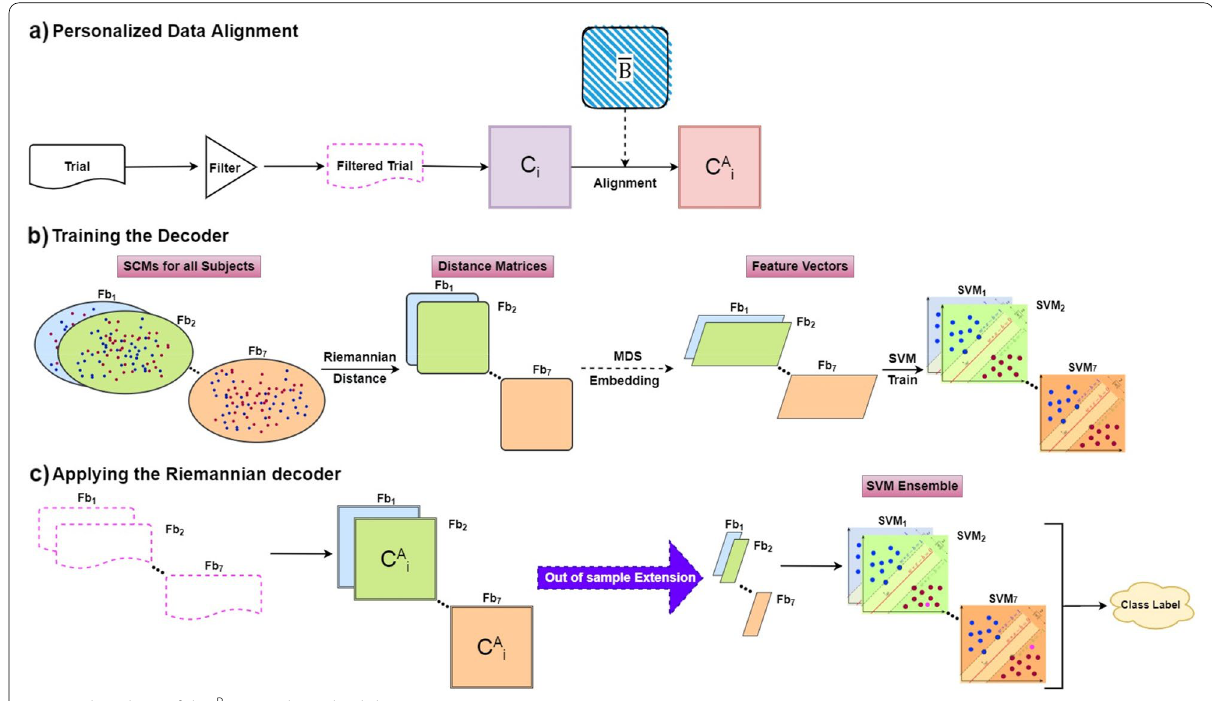
Fig. 1 Flowchart of the R NeuMark